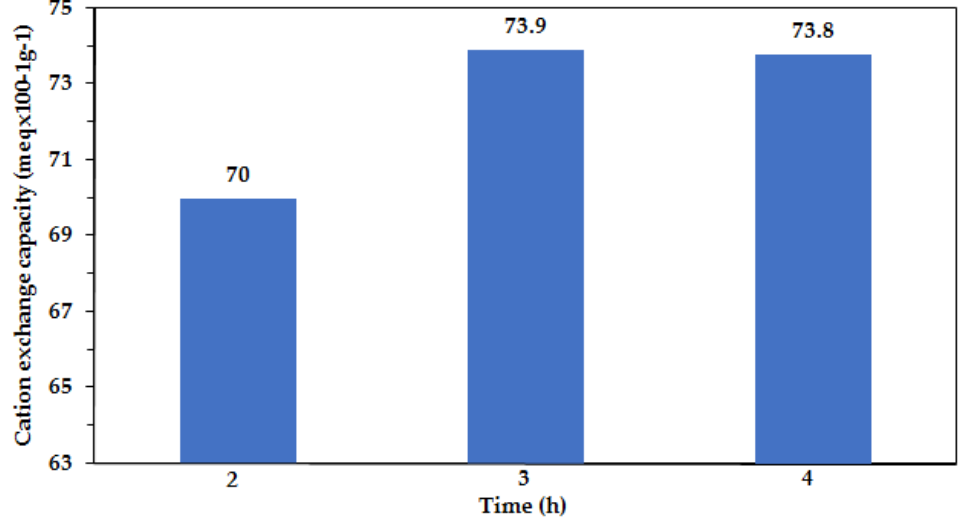
Figure 6. Effect of time on CEC at a fixed Na 2 CO 3 concentration (4 wt.%) and temperature (45 °C).